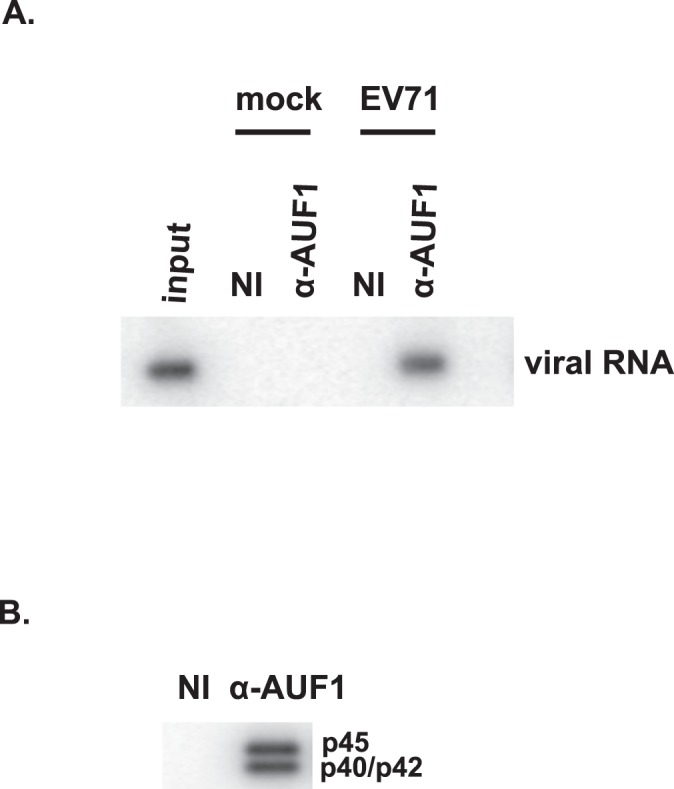
AUF1 associates with EV71 RNA in infected cells.(A) Lysates of mock- or EV71-infected SF268 cells were prepared and analyzed by ribonucleoprotein immunoprecipitation (RIP) with non-immune serum or AUF1 anti-serum. Both input and immunoprecipitated materials were analyzed by Northern blotting for EV71 RNA. NI, RIP with non-immune serum. (B) Aliquots of immunoprecipitated materials were analyzed by Western blot to verify anti-AUF1–dependent recovery of AUF1. The AUF1 isoforms are indicated.